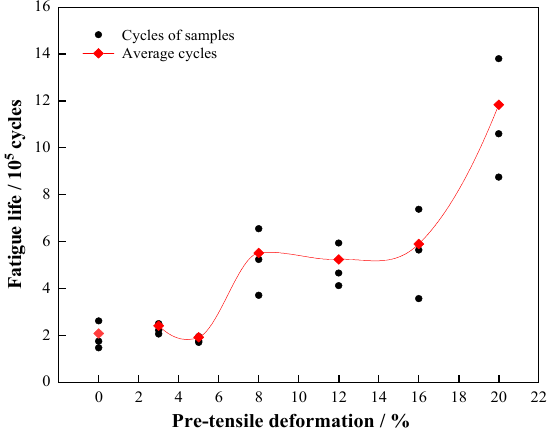
Figure 8. Fatigue life of annealed 7005 aluminum alloy plates subjected to different pre-tensile deformations (stress level, 155 MPa; stress ratio (R) = 0).